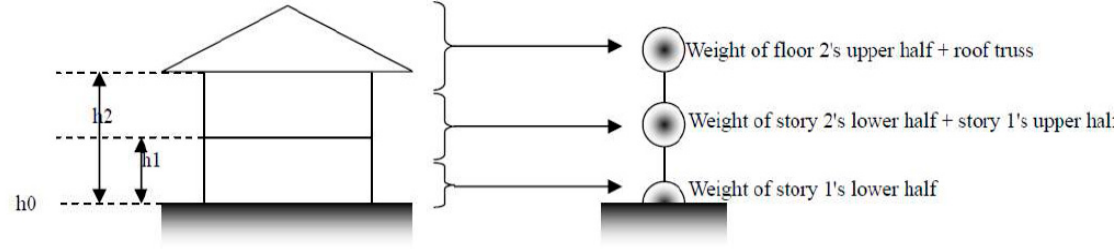
Figure 2. Weight modeling of each floor of a wood house model. (Suwantara and Suryantini, 2014).